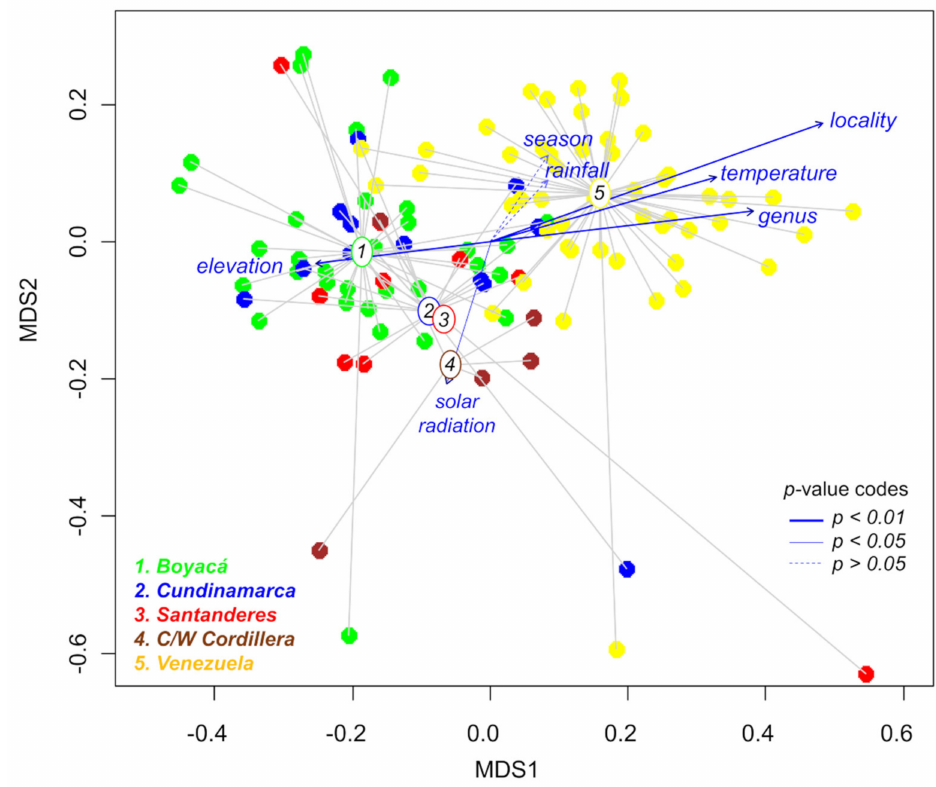
Figure 6. Non-metric multidimensional scaling (NMDS) showing the correlation between the metabolic fingerprints (represented by 4181 variables) of 109 taxa of Espeletiinae obtained by ultrahigh-performance liquid chromatography-high-resolution mass spectrometry (UHPLC-HRMS) in negative ion mode and their geographic localities, taxonomic genus, elevation, and environmen- tal